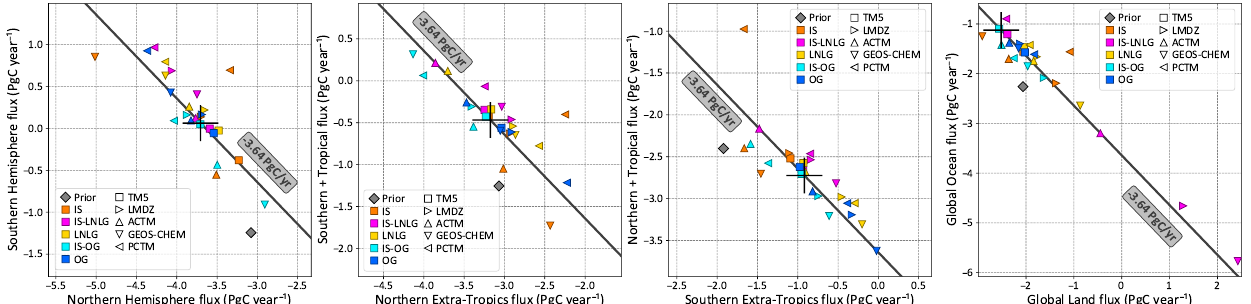
Figure 8. The partitioning of the 2015 global CO 2 sink into two geographical domains, with the tropics being defined as 23.5 ◦ N and S latitudes. This is similar to Fig. 7, except that we have compared two real OCO-2 and one real in situ sampling schemes (LNLG, OG, IS) with the two theoretical in situ ones (IS-LNLG, IS-OG) of Sect. 2.3.3. The scales are identical across three of the four figures and the same as Fig. 7; the partitioning of global and ocean fluxes had significantly more spread and required a different